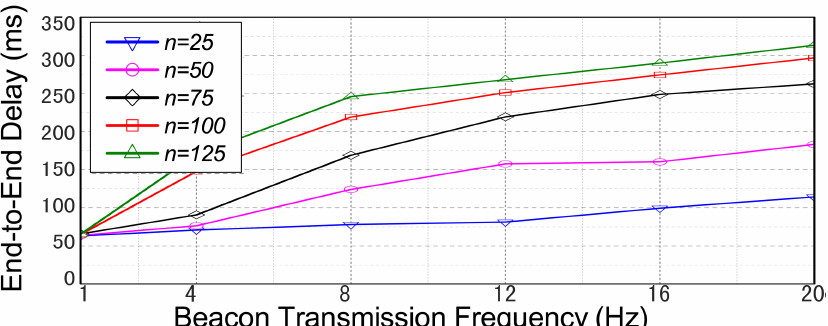
Figure 7. End-to-end delay (ms) vs. Average Speed